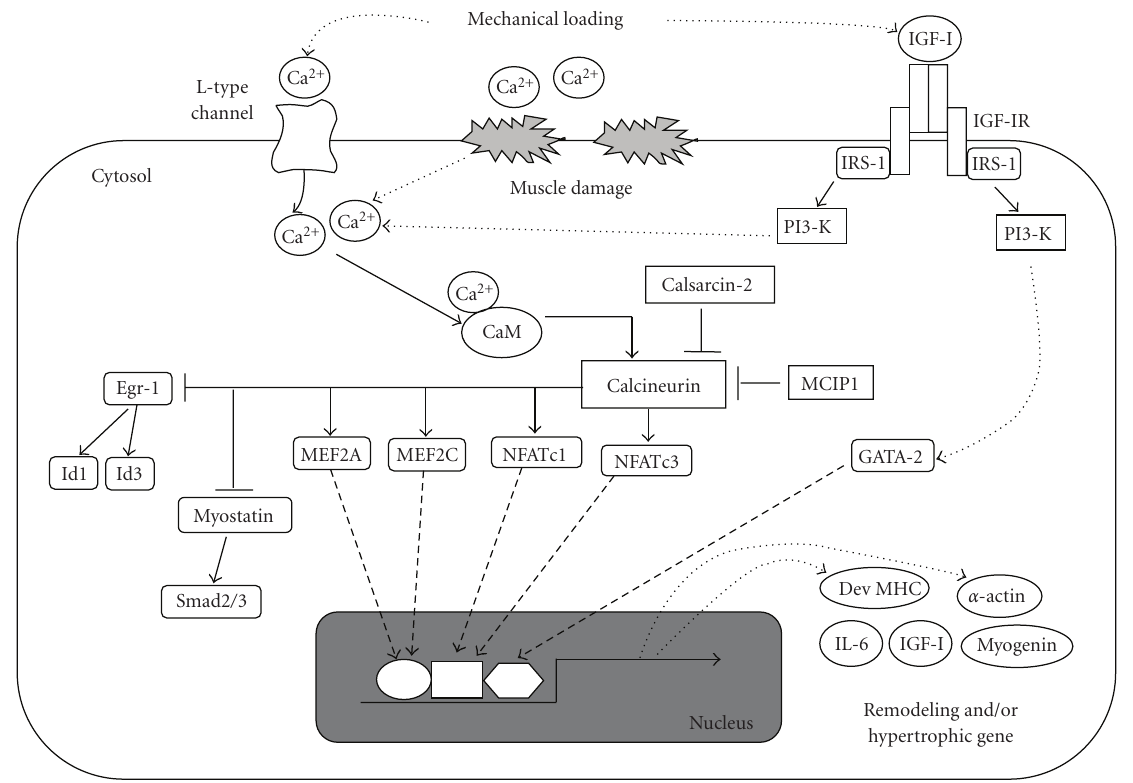
Figure 1: Schematic diagram of calcineurin signaling to regulate hypertrophy and regeneration of skeletal muscle. Mechanical loading of skeletal muscle increase intracellular Ca 2+ levels via the influx (L-type Ca 2+ channel) of Ca 2+ from the extracellular space and its e ffl ux from the sarcoplasmic reticulum. The damage of muscle fiber membrane after treatment with myotoxin also elicits an increase in intracellular Ca 2+ levels via the influx of Ca 2+ from the extracellular space. Binding of the Ca 2+ /CaM complex to the calcineurin regulatory subunit leaded to its activation. Activated calcineurin dephosphorylates NFATc1 [26, 65, 70], NFATc3 [23], MEF2C [59], and MEF2A [29, 70] resulting in their translocation from the cytoplasm to the nucleus. These transcription factors induce the expression of hypertrophic and/or remodeling genes such as Dev MHC [29], α -actin, IGF-I [71], myogenin [25], and IL-6 [72]. In addition, activated calcineurin inhibits the functional role of Egr-1 [25] and myostatin [32–34]. Mechanical overloading upregulates gene expression of IGF-I. IGF-I modulates calcineurin signaling via increasing intracellular Ca 2+ levels [25] and activating GATA-2 [50, 73]. MCIP1 [58] and calsarcin-2 [17] are potent inhibitors of calcineurin signaling. MEF2A: Myocyte enhancer factor 2A; NFATc1: nuclear factor of activated T cells c1; MCIP1: Modulatory calcineurin-interacting protein 1; IRS-1: Insulin receptor substrate-1; PI3-K: Phosphatidylinositol 3-kinase; CaM: Calmodulin; Dev MHC: Developmental myosin heavy chain; IL-6: